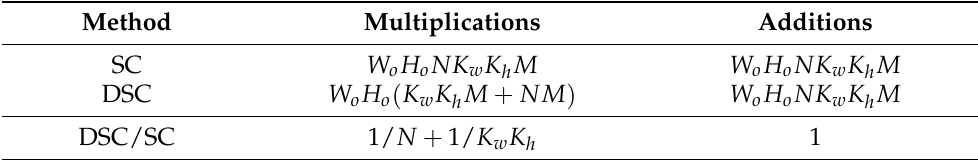
Figure 2. DSC residual unit and DSC residual stack. Table 1. Complexity comparison between SC and